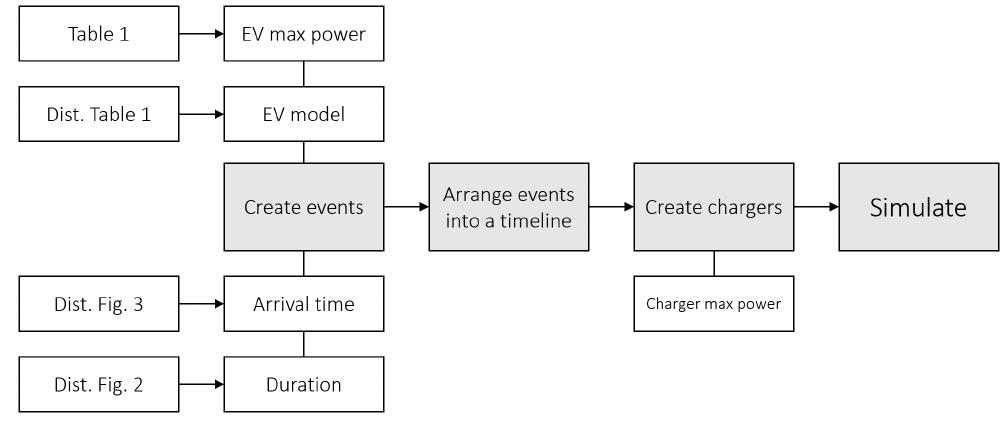
Figure 4. Simulation